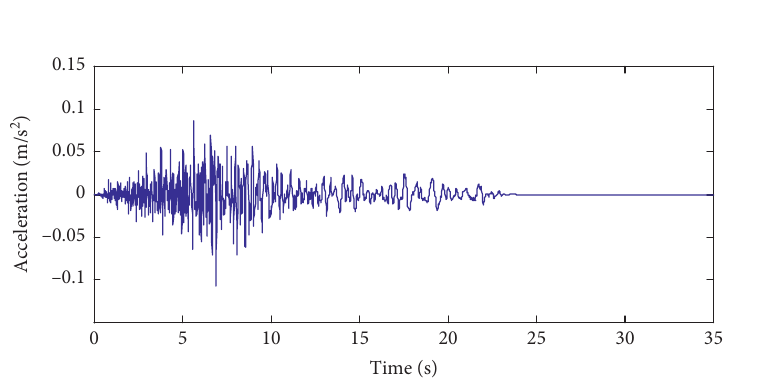
Figure 7: Time-history curve of acceleration (C1).